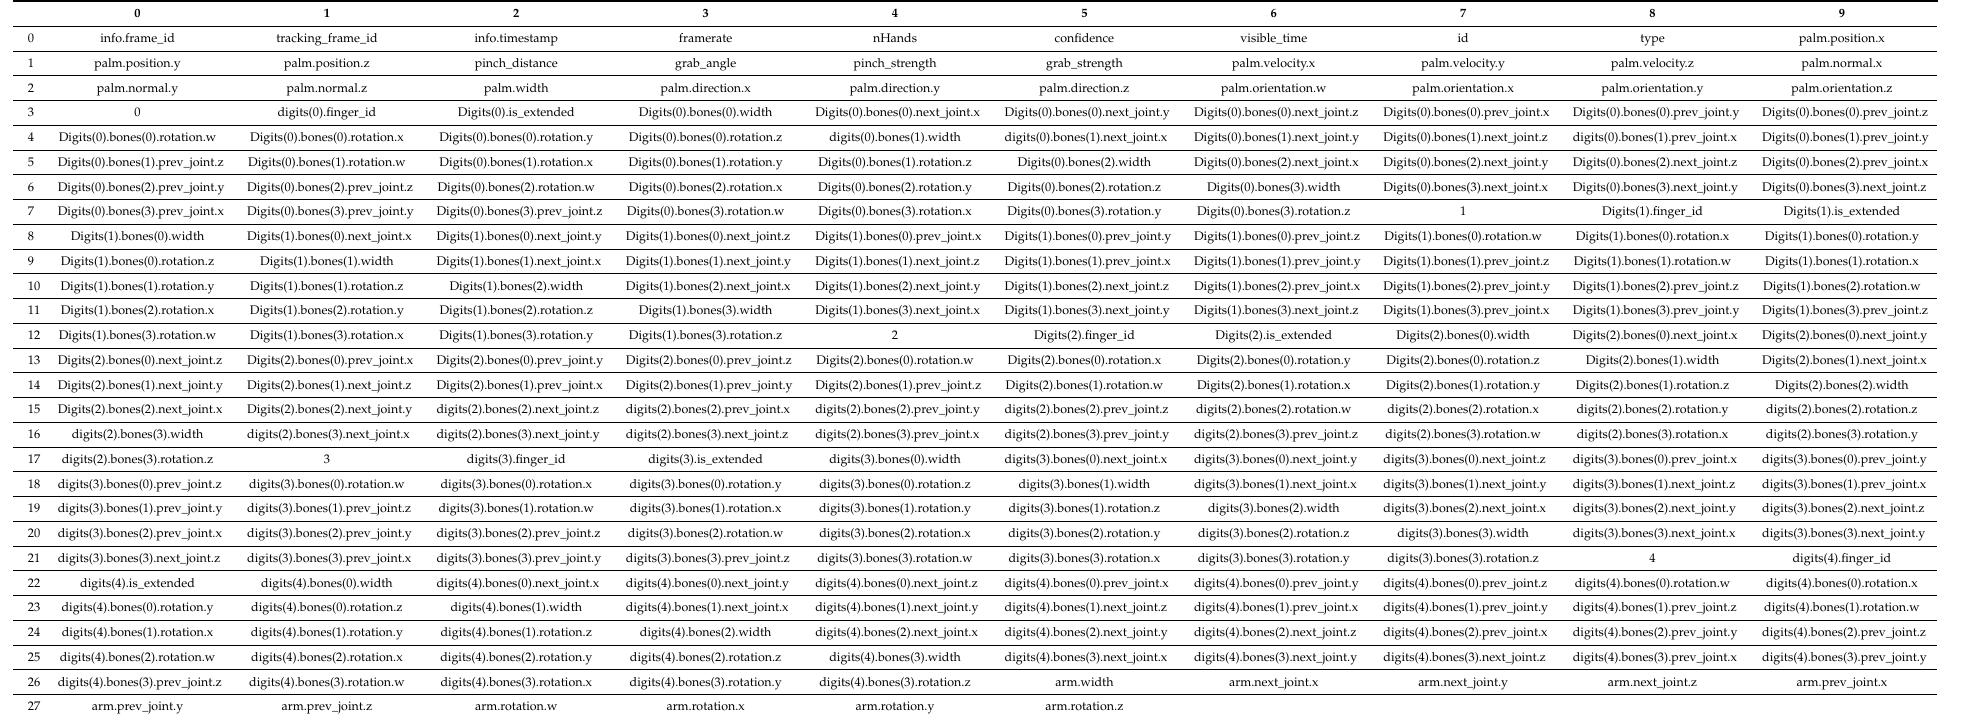
Table A1. Leap Motion parameter